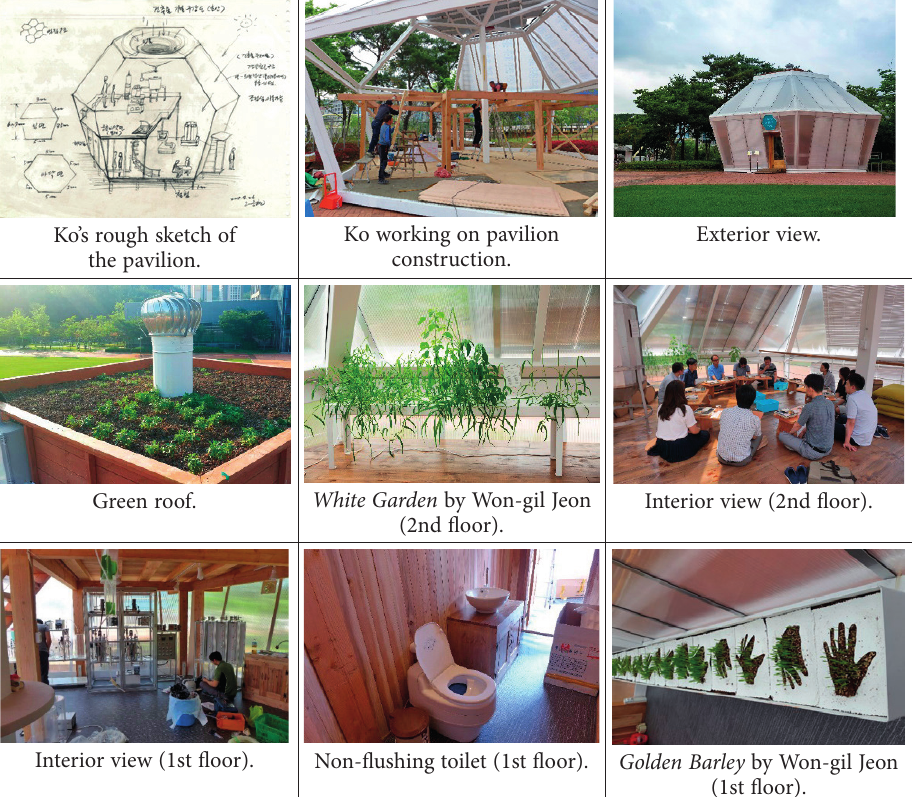
Ko’s rough sketch of the